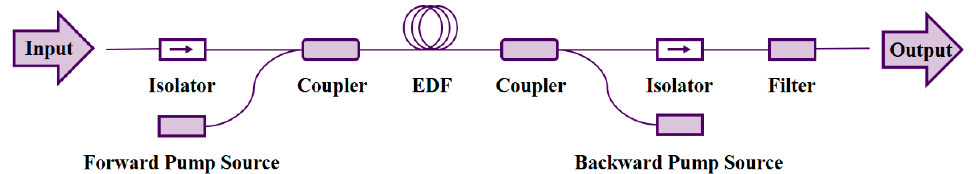
Figure 2. Basic structure of erbium-doped fiber amplifier. However, to achieve a better performance such as lower noise power, and to